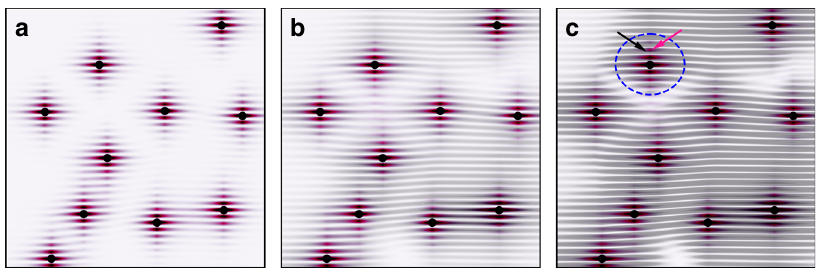
T < T (62 K in Fig. 3), b T ≲ T (47 and 56 K in LO < CDW LO